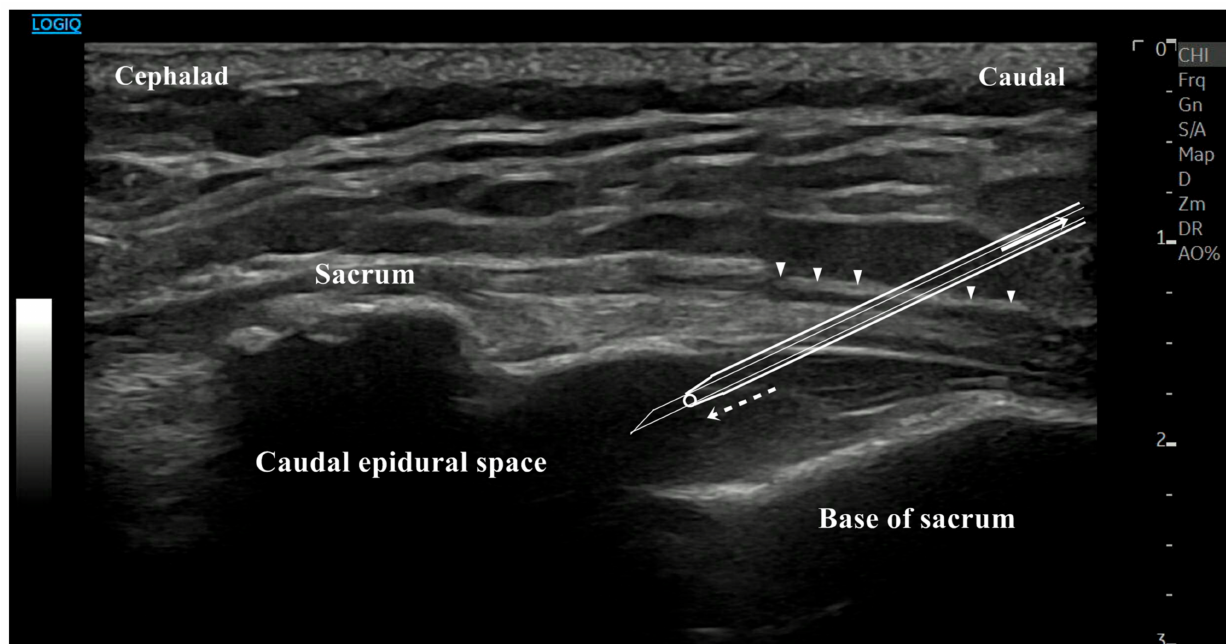
Figure 1. Sonographic image and schematic drawing of the ultrasound (US)-guided technique with an angiocatheter for caudal block. The outer catheter is advanced beyond the sacrococcygeal ligament (white arrow heads) into the caudal epidural space (dotted white arrow). The metallic guide needle should be withdrawn without making contact with the sacral bone (white arrow).